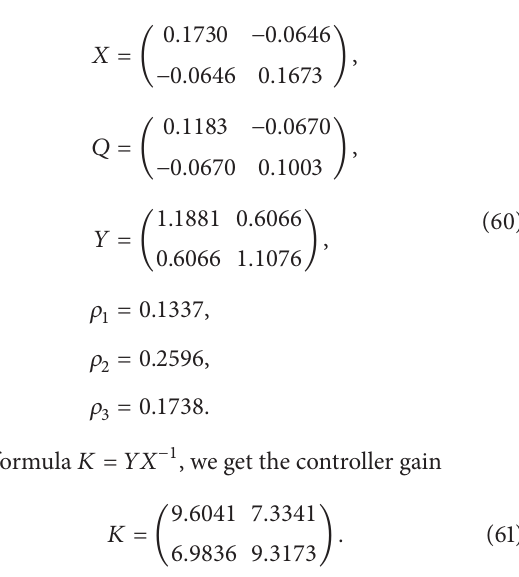
Given that 𝛼 = 1.25, 𝛽 = 0.8, 𝜏 𝑀 = 3 , and 𝜏 𝑚 = 1 , then the solution of LMI (40)